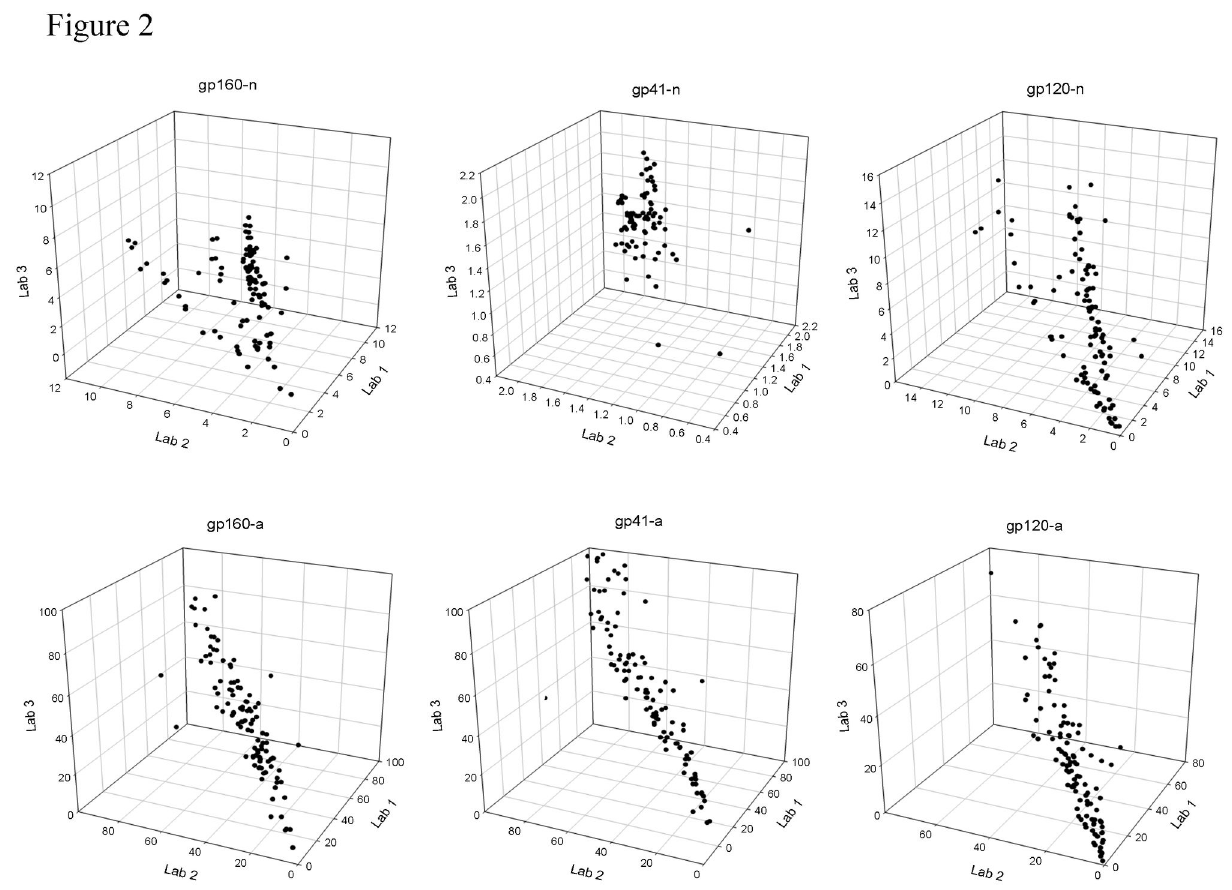
Figure 2. Inter-laboratory reproducibility of kit measures. The normalized MFI values and avidity index of longitudinal seroconversion panels were compared for the three participating laboratories. The values for each laboratory were plotted on a separate